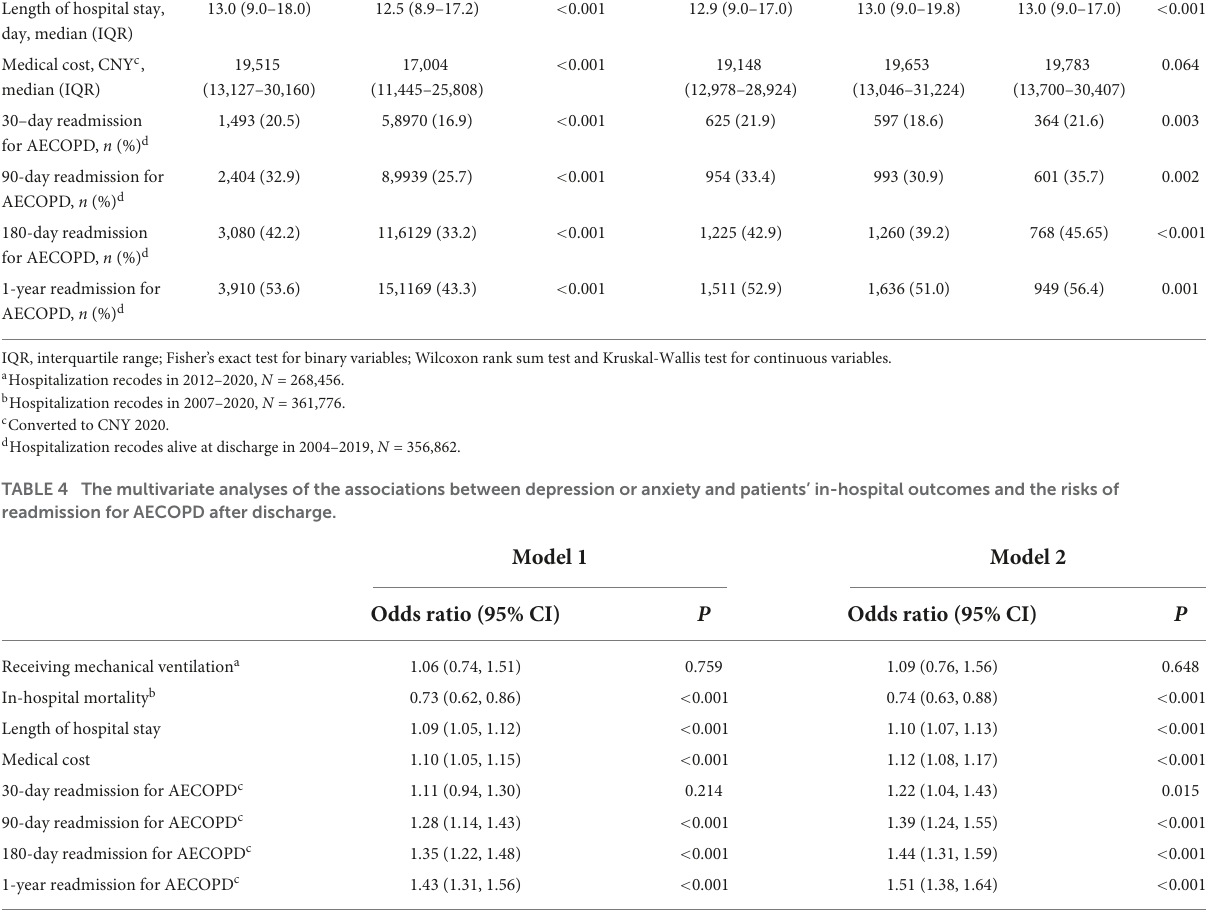
Hamilton Anxiety Rating Scale (HAMA) were used to detect AECOPD patients suffering from anxiety and/or depression (3, 8, 20). Accordingly, these studies reported higher prevalence of anxiety and depression than we did (ranging from 44.4 to 68.2%) (3, 8). It should be noted, however, that anxiety and depression based on scales may be affected by AECOPD symptoms (27), these measures are not comparable to the clinical diagnoses